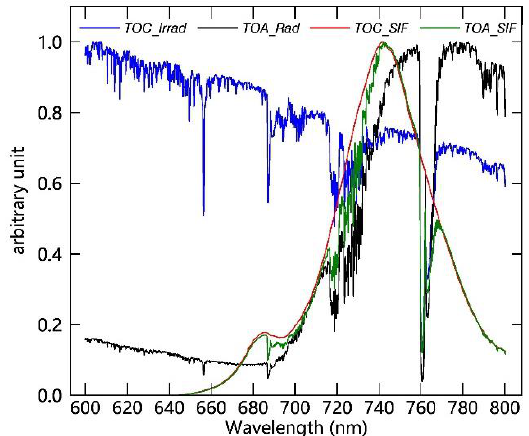
Figure 6. A single group of normalized simulated top-of-atmosphere (TOA) radiance spectra over vegetated surfaces (black), incident solar radiance reaching the top-of-canopy (TOC) (blue), TOC SIF (red), and TOA SIF (green) with 0.3 nm spectral resolution and 0.1 nm sampling interval derived from SCOPE and MODTRAN 5 models.